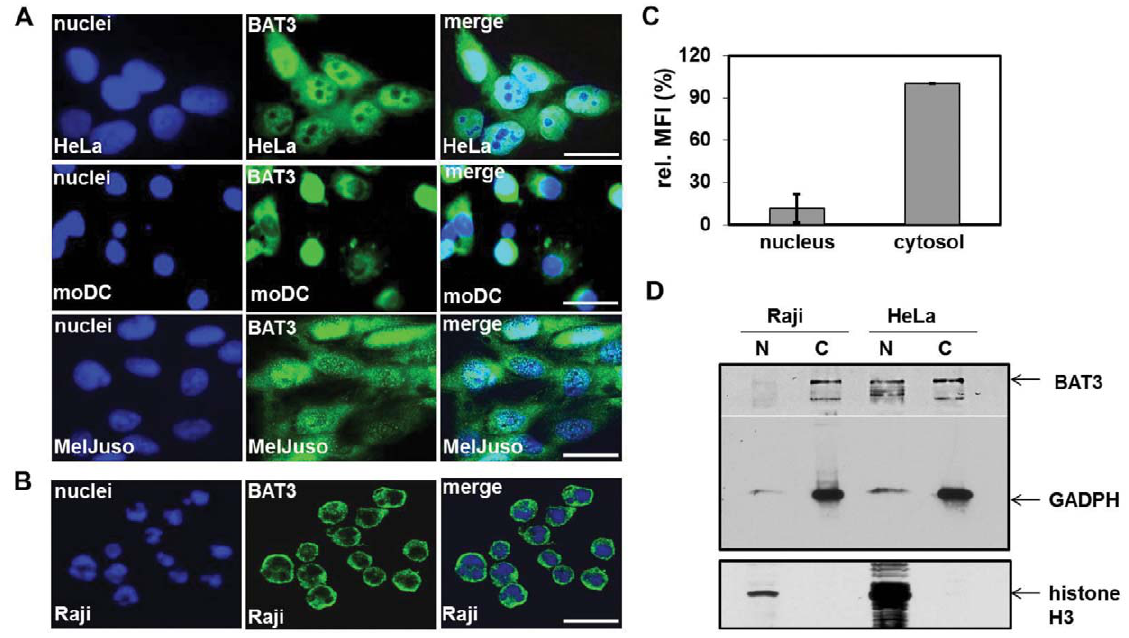
Figure 4. Subcellular localization of endogenous BAT3 in four cell types. HeLa cells (Adenocarcinoma), the human melanoma cell line MelJuSo, the B lymphoma Raji and monocyte-derived dendritic cells (moDCs) were plated on coverslips and stained for BAT3 using a polyclonal serum against a C-terminal peptide (middle lane). Cell nuclei (left lane) were visualized with DAPI (A) or 7AAD (B). Merged images are shown in the right lane. A. Immunofluorescence staining was evaluated with a standard fluorescence microscope and B. by confocal microscopy. Scale bars=10 m m. C. Nuclear and cytosolic staining of endogenous BAT3 in Raji cells was evaluated in 10 single cells using ImageJ. MFI, mean fluorescence intensity per region of interest D. Western blot analysis of subcellular fractions from Raji and HeLa cells. Nuclei (N) and cytoplasm (C) were separated by SDS-PAGE and immunoblotted for BAT3, GADPH (cytosolic marker) and histone H3 (nuclear marker).